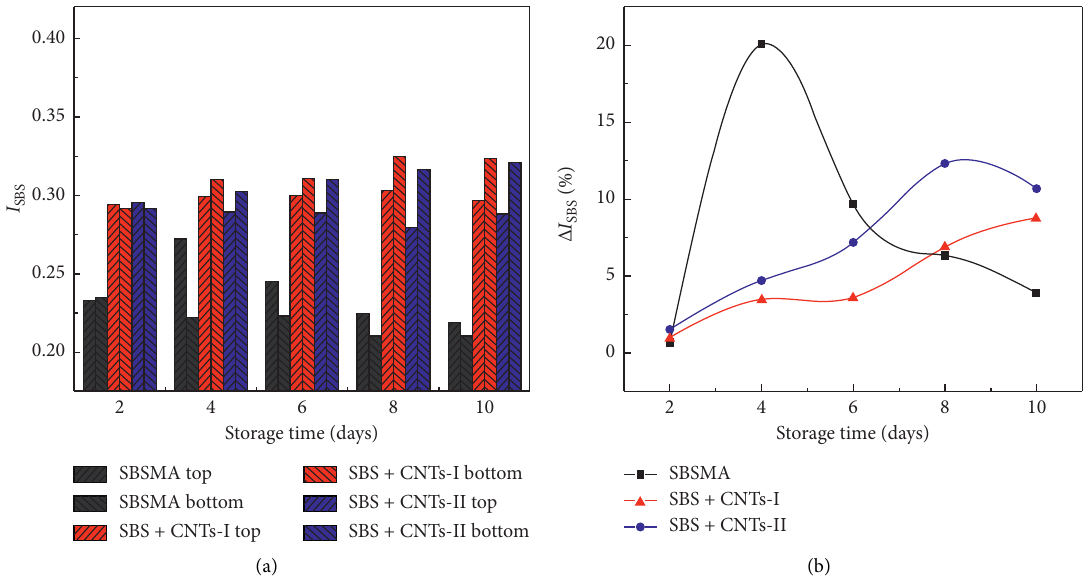
Figure 13: Characteristic peak area ratio separation and degree of three modified asphalts based on infrared spectra. (a) Changes of I Degree of separation based on I SBS